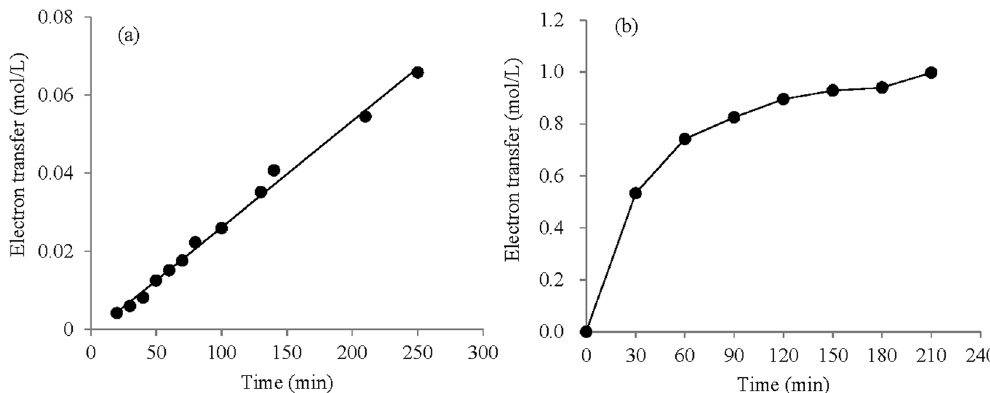
Figure 7. Numbers of electron transfer during redox reaction of PW 12 ( a ) or PMo 12 ( b ) and glucose (The concentrations of PW 12 and glucose were 0.3 and 2 mol/L, respectively; the concentrations of PMo 12 and glucose were 0.1 and 0.6 mol/L, respectively; the concentration of phosphoric acid in anolyte was 1.5